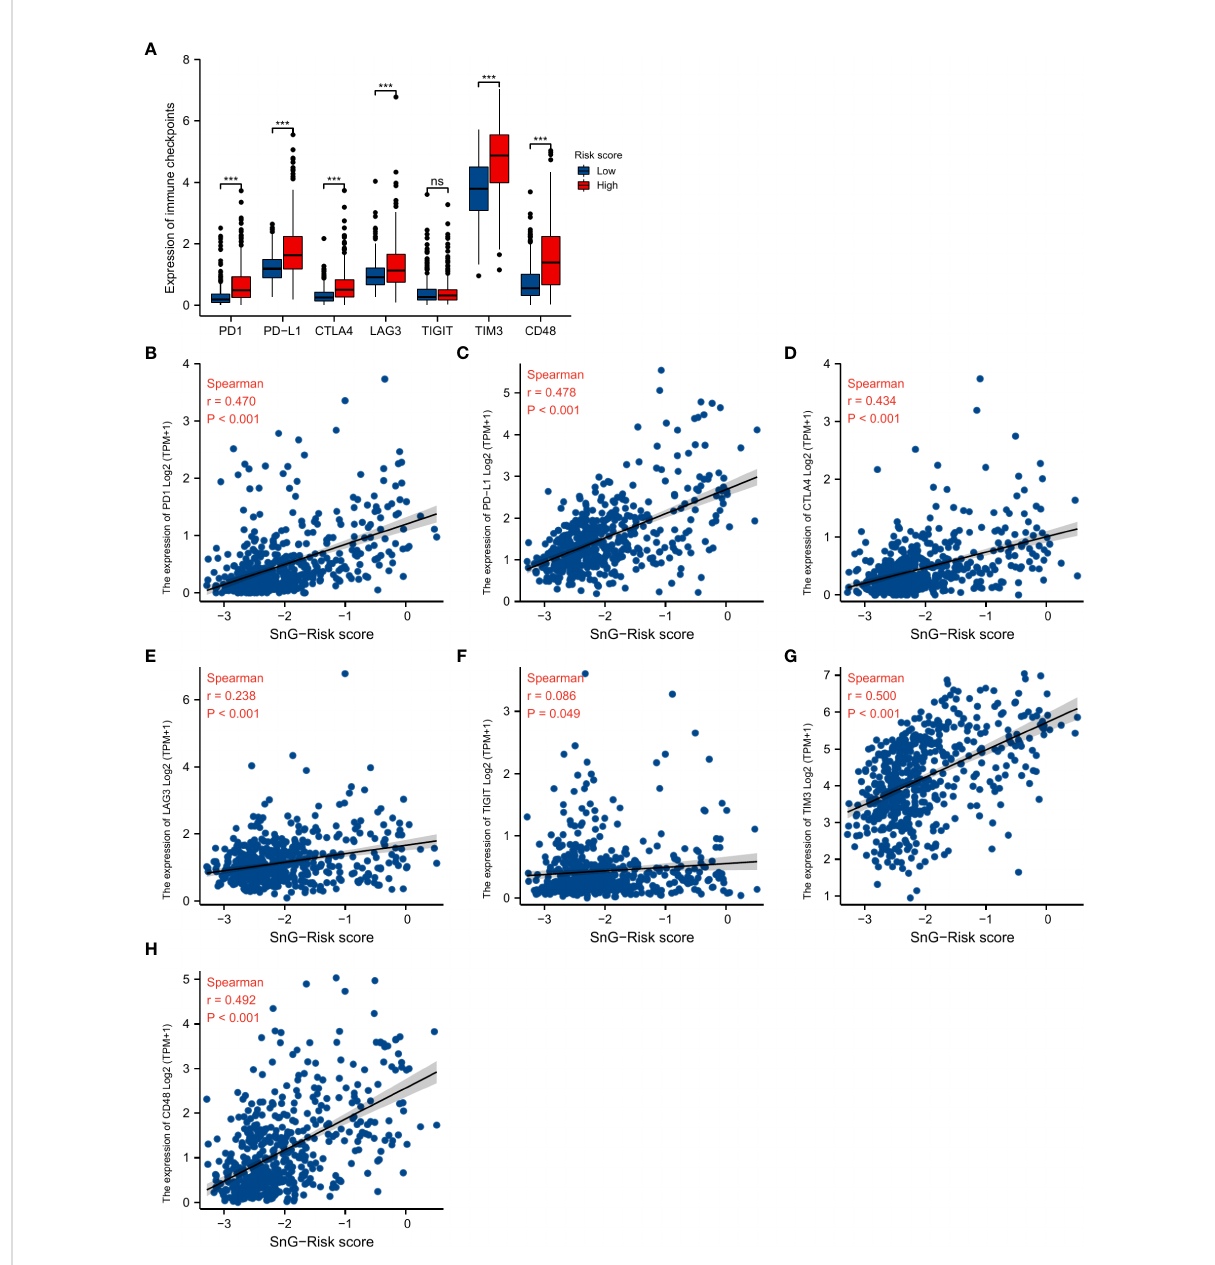
FIGURE 9 Association between SnG-risk score and immune checkpoint expression. (A) The expression levels of immune checkpoints in low and high risk levels. (B – H) Correlation between SnG-risk score and expression levels of immune checkpoints. *P<0.05; ***P<0.001; ns, not signi fi